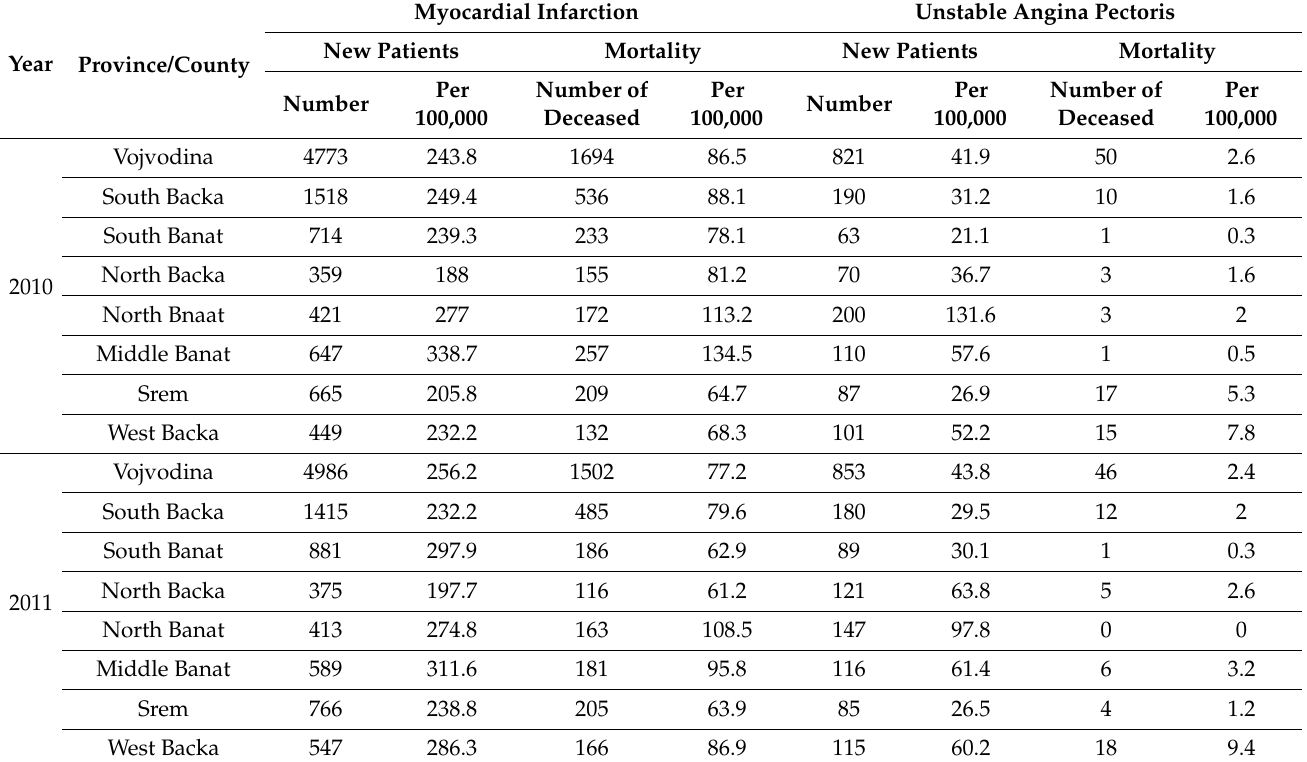
Table A2. Number of newly diagnosed and deceased patients, as well as the incidence and mortality rates from myocardial infarction and unstable angina